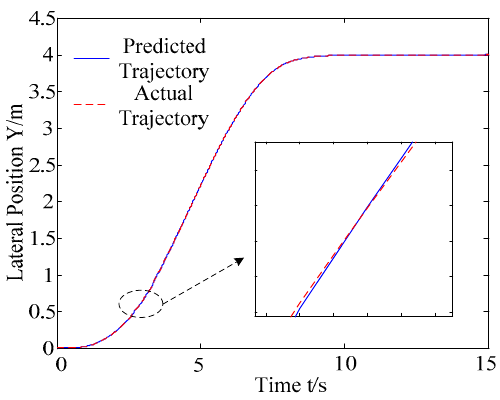
Figure 14. Trajectories with the actual trajectory and the predicted trajectory of the obstacle.